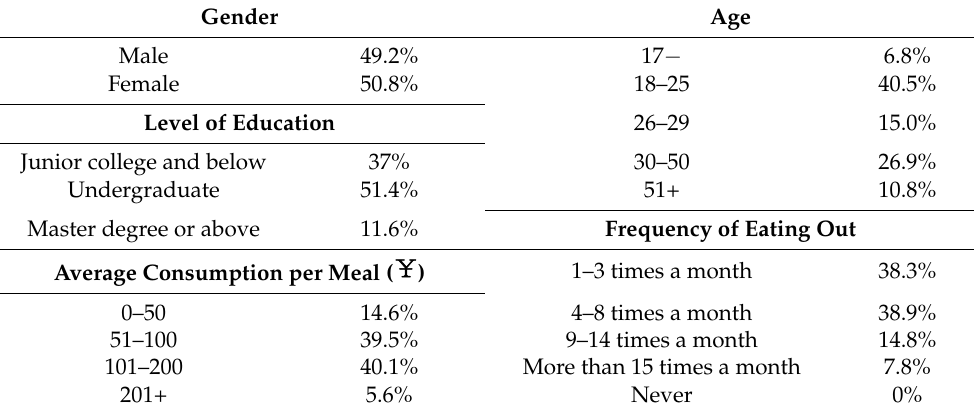
Table 2. Sample characteristics.